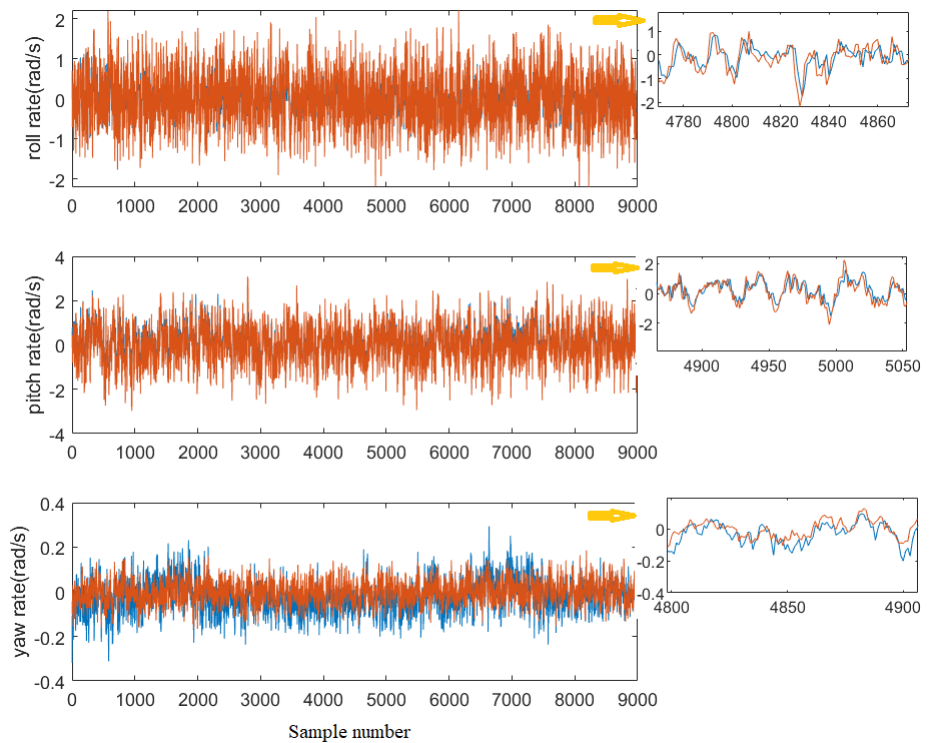
Figure 12. Estimated angular rates of the LSTM test set: red line represents LSTM output; blue line represents sample